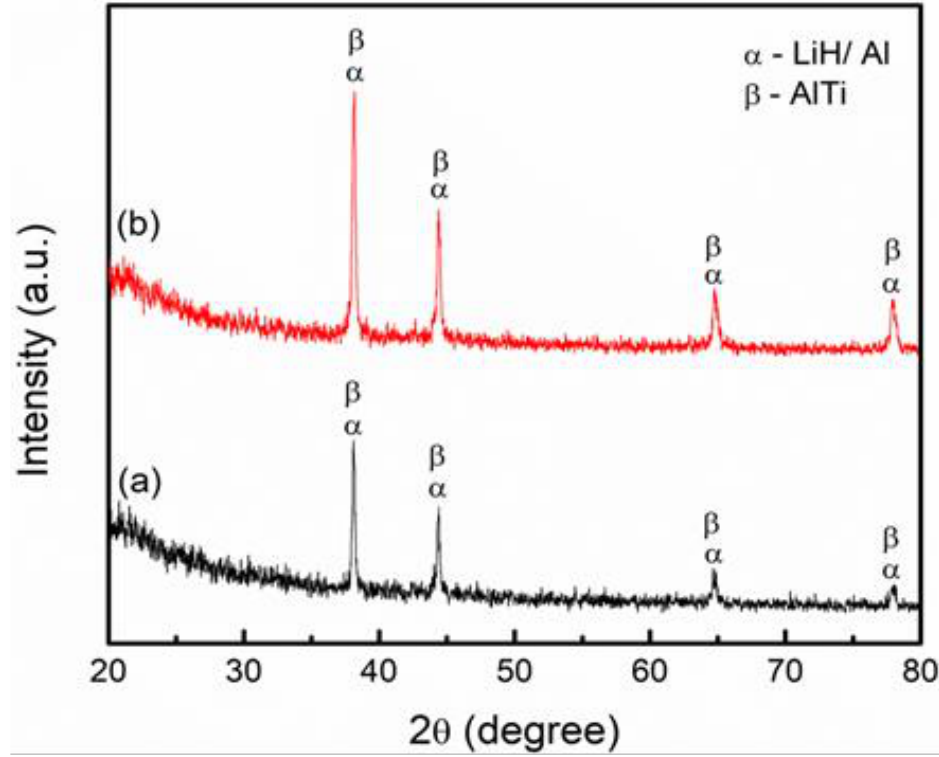
Figure 8. XRD pattern of the dehydrogenation at 250 °C of the added LiAlH 4 with ( a ) 10 wt% and ( b ) 20 wt% of TiSiO 4 .